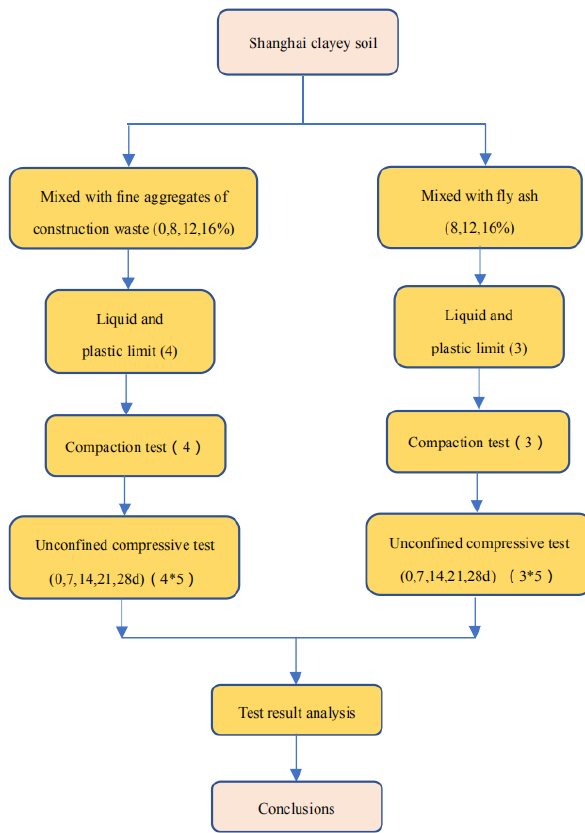
Figure 3: Road map for test scheme on the composites (The num- bers in the box mean number of sample used. Each test is repeated 3